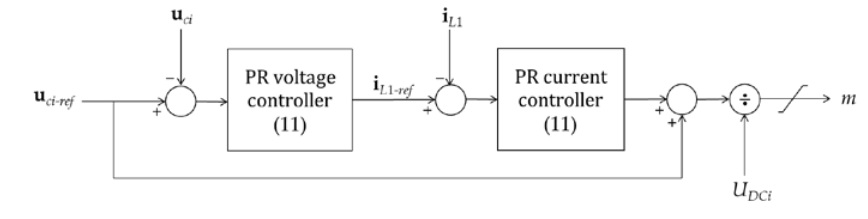
Figure 3. Converter inner control loops.